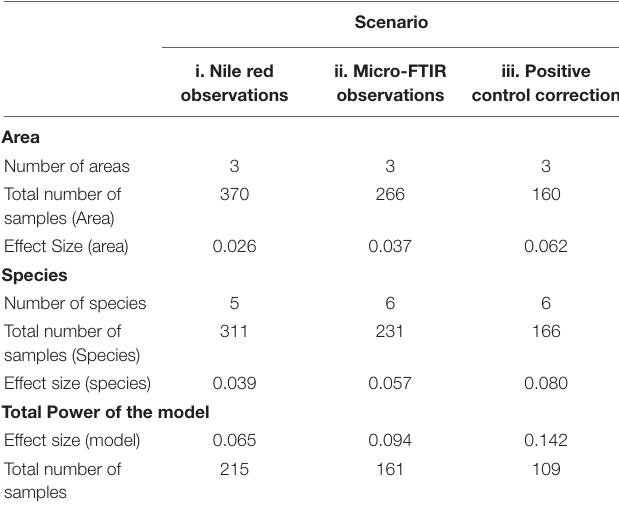
TABLE 4 | Sample size estimates (power analysis) for three scenarios (with a balanced set-up), based on the results obtained for the number of MPs in single fish GIT samples observed. Power was set at